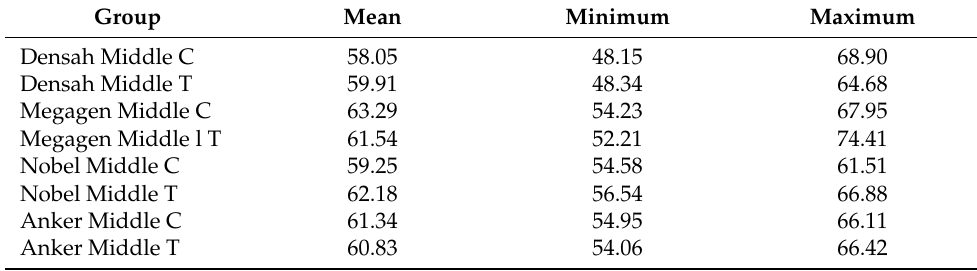
Table 4. Descriptive statistics. Relative bone condensation at the middle